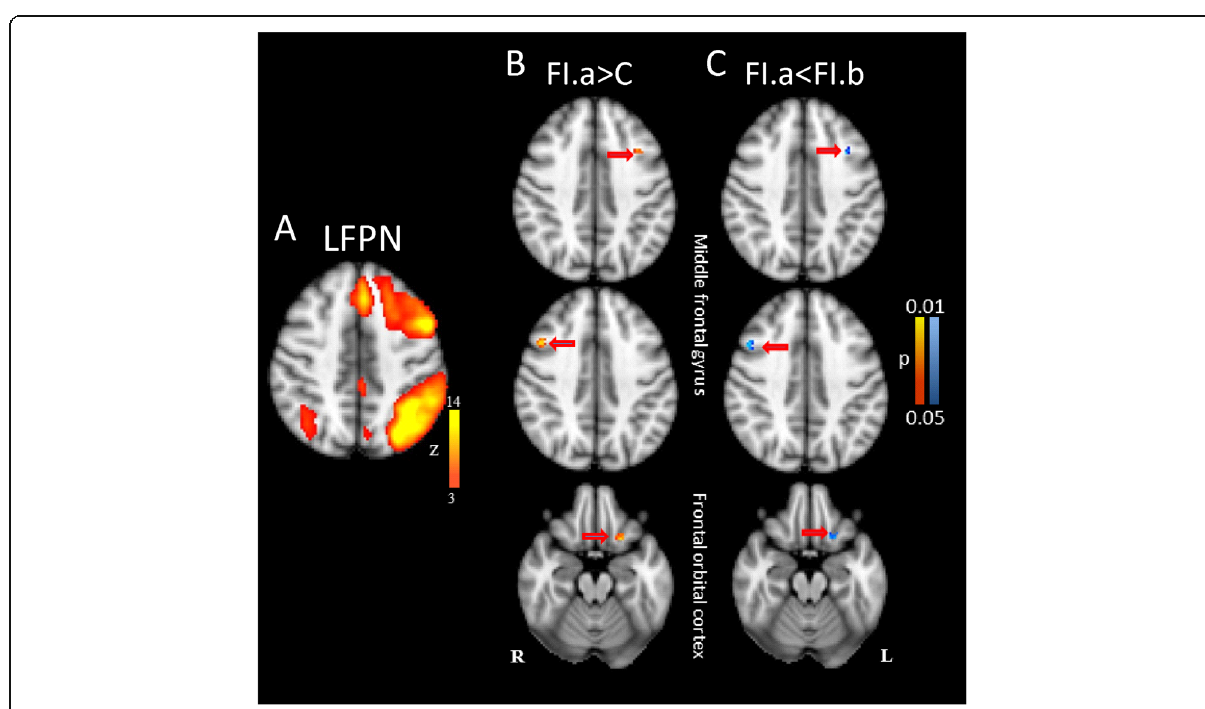
Fig. 1 a left Fronto-Parietal Network (LFPN) as revealed by ICA. b Between group comparison in LFPN comparing functional illiterates before training (FI.a) and control group (C). b Training induced changes in LFPN in the FI group: Training led to a normalization. All data are FWE- corrected for multiple comparisons ( p < 0.05)